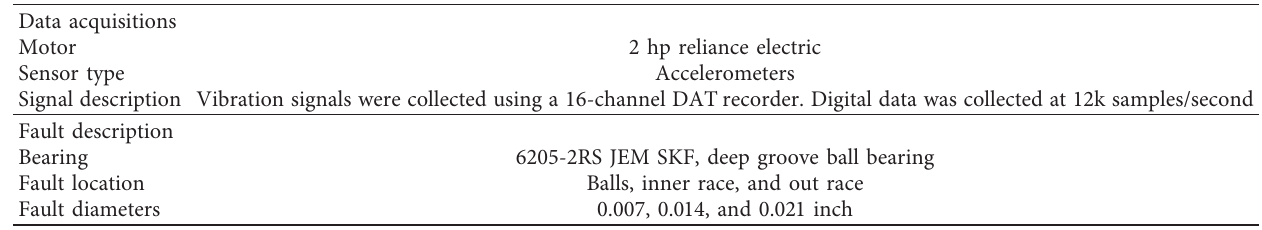
Table 2: Description of the CWRU dataset.